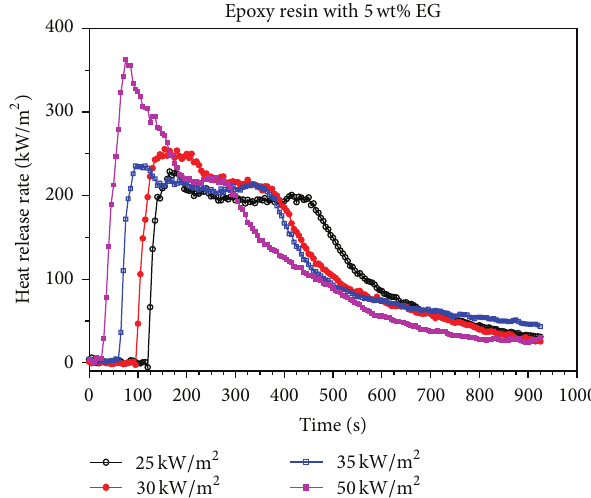
Figure 5: HRR profile epoxy-5 wt.% EG subjected to different exter- nal heat fluxes.